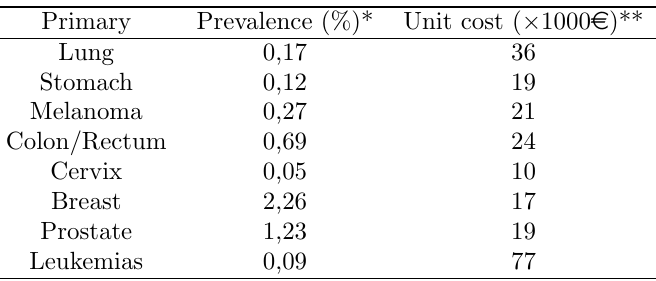
Unit treatment costs and prevalence by tumor primary